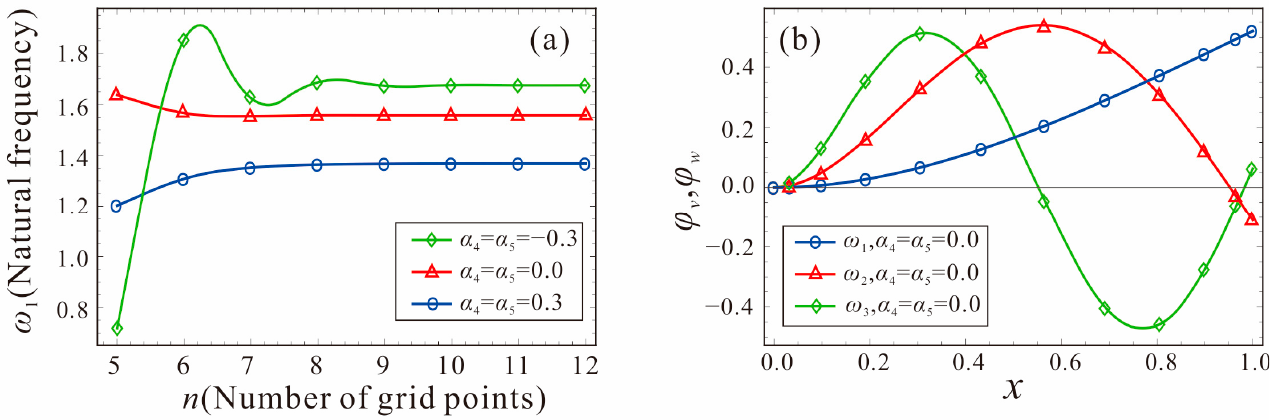
Figure 6. Natural frequency and the first three orders of mode shapes of the tapered beam: ( a ) Natural frequency, ( b ) Mode shapes.